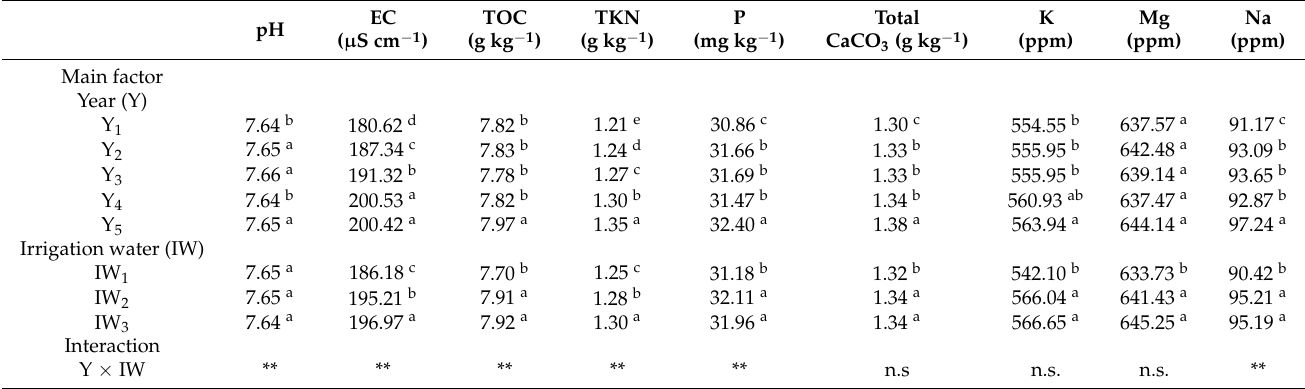
Table 6. Chemical characteristics of soil in response to year and irrigation water during the study period. Average values of 5-year tests are